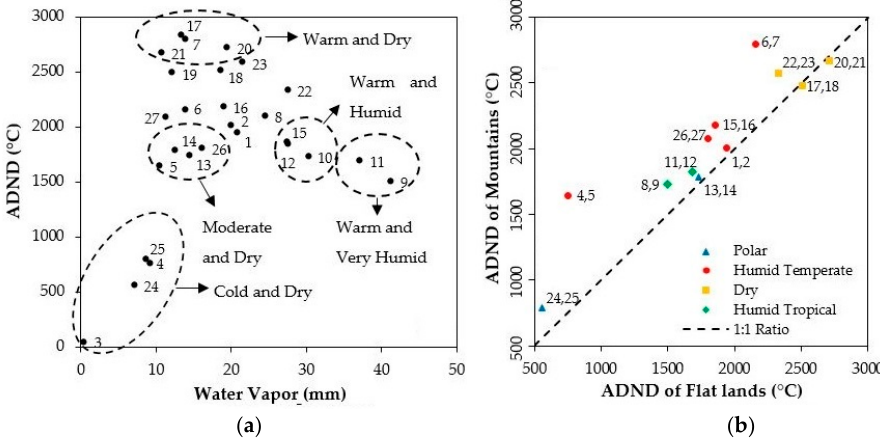
Figure 2. Average day-night differences (ADND) thermal time variations across eco-regions of the Western Hemisphere [26] as a function of precipitable water vapor ( a ) and contrasting elevation ( b ). Labels are ecoregion’s identification numbers as provided in Figure S1.